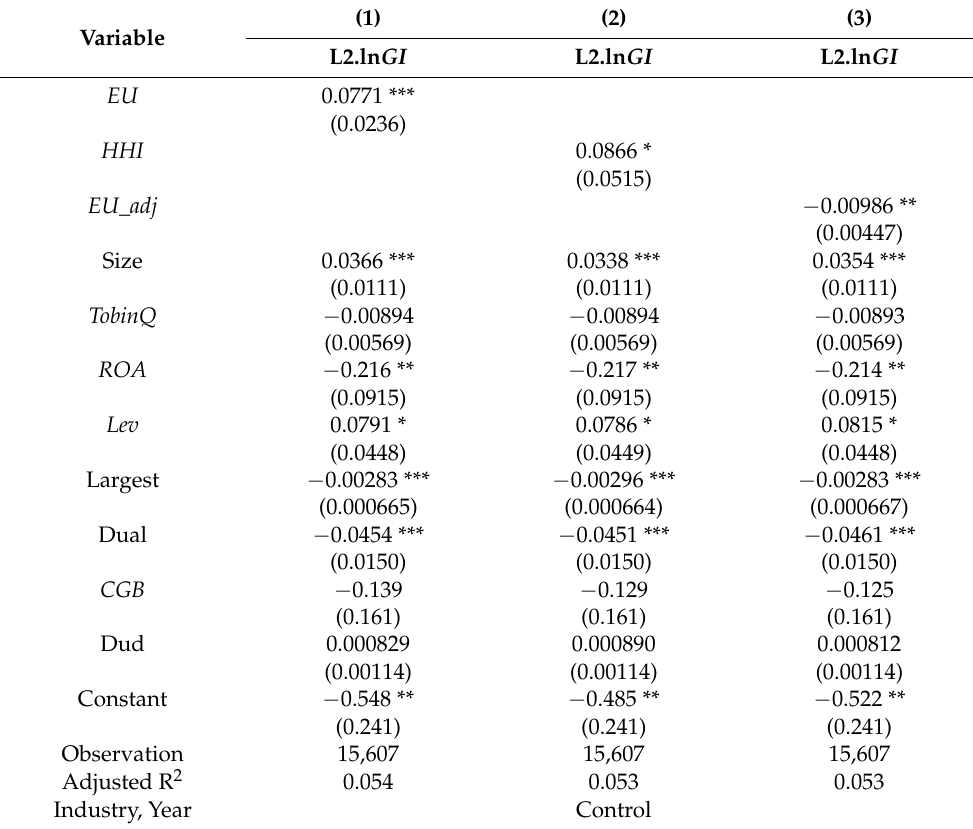
Table 12. Regression Analysis of Environmental Uncertainty and Enterprises’ Green Technological Innovation Lagging Two